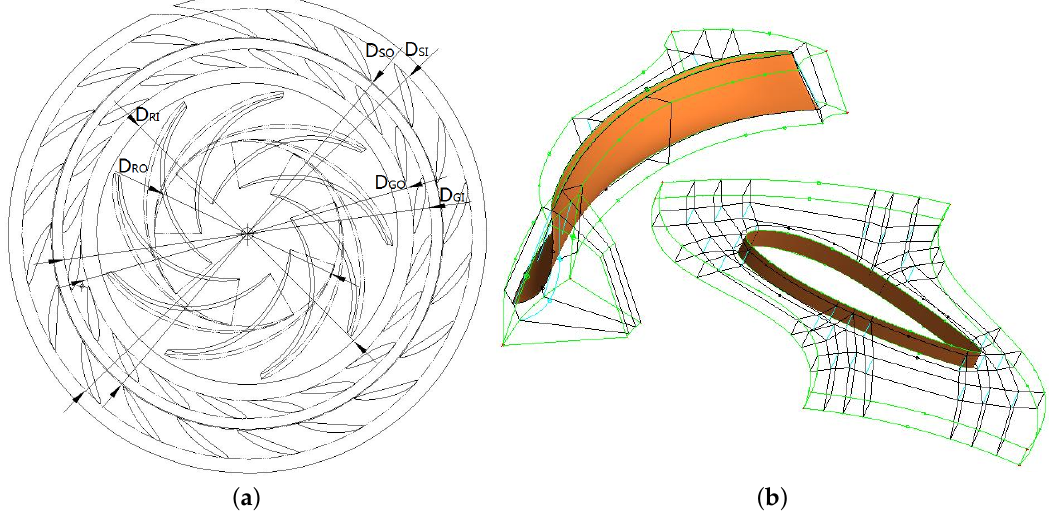
Figure 2. Sketch of the stay vane. ( a ) Guide vane and runner with the references of the main diameters; and ( b ) the mesh topology blocks adopted for the runner blade and the guide vane.